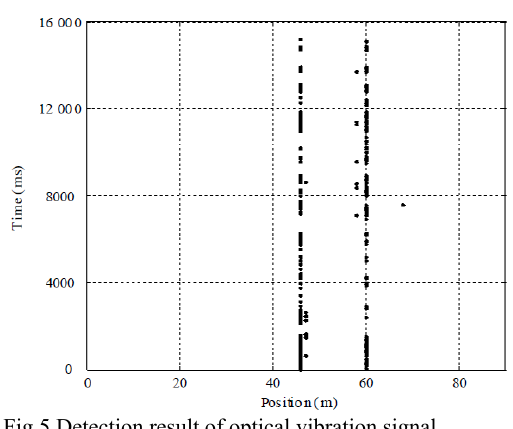
Fig.5 Detection result of optical vibration signal.